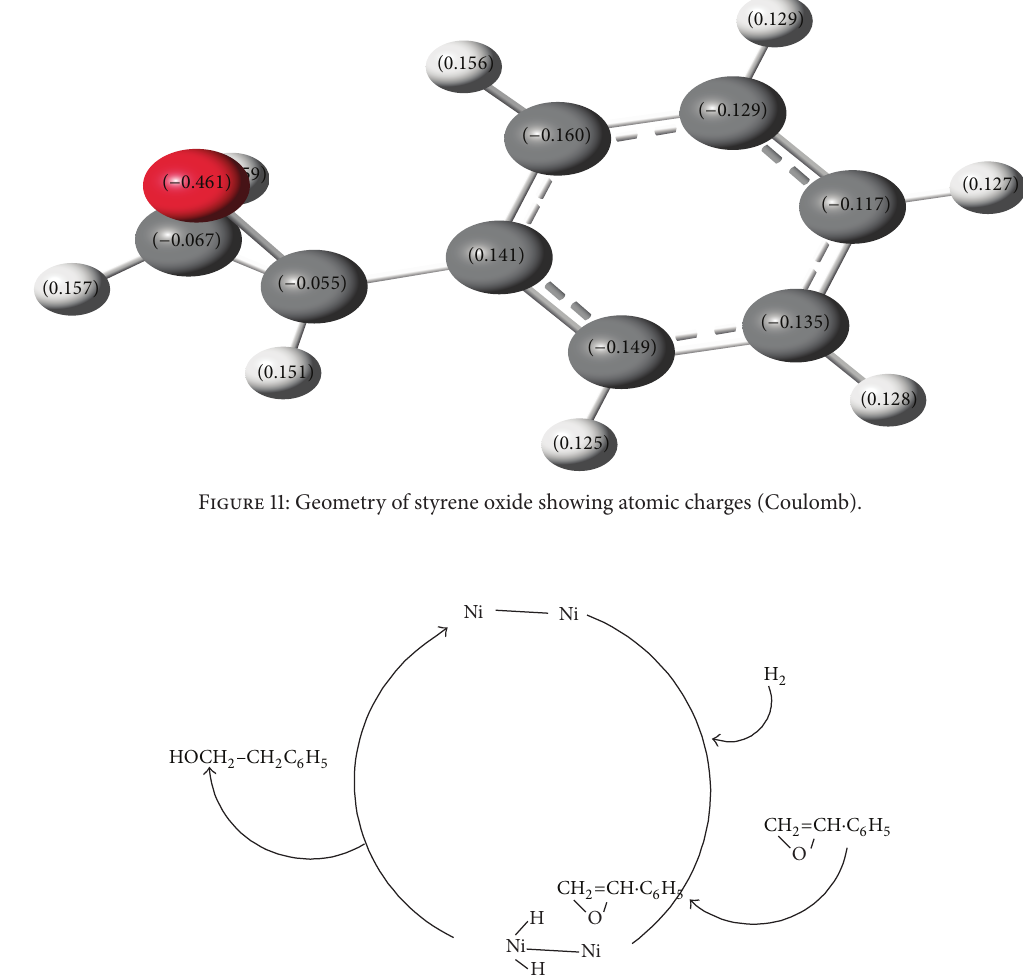
Figure 12: Model of the catalytic cycle for hydrogenation of styrene oxide over Ni